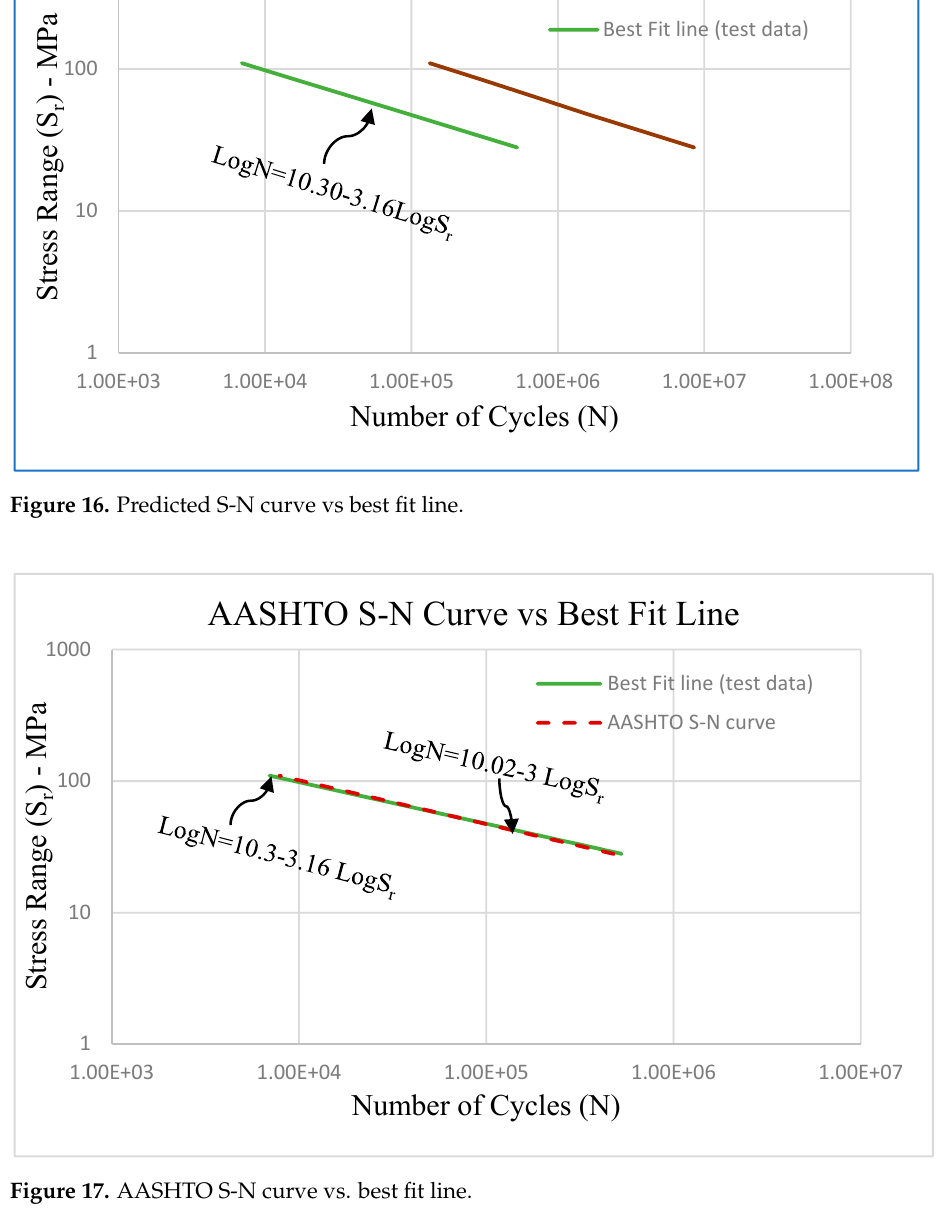
Figure 17. AASHTO S-N curve vs. best fit line.